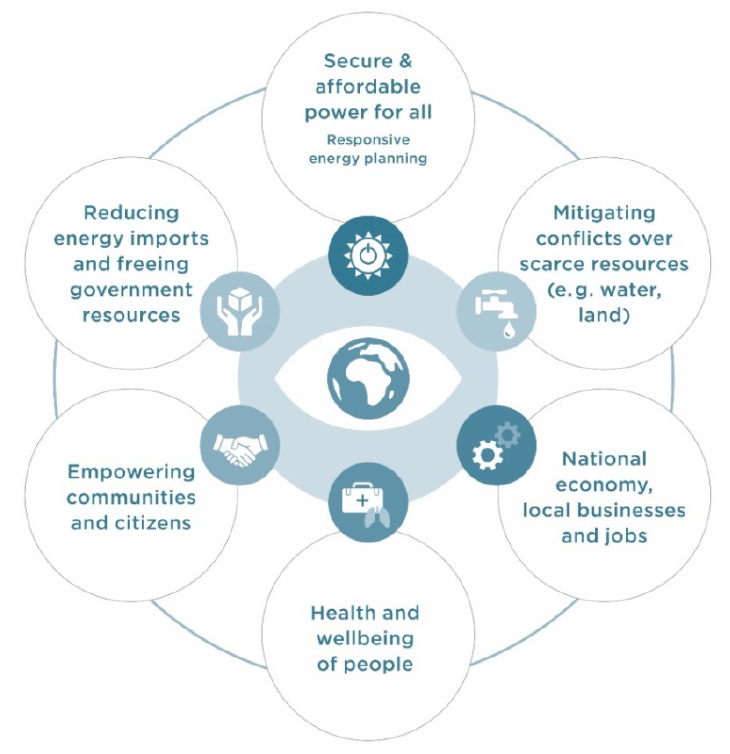
Figure 1 : Social and economic co-benefits of a global energy